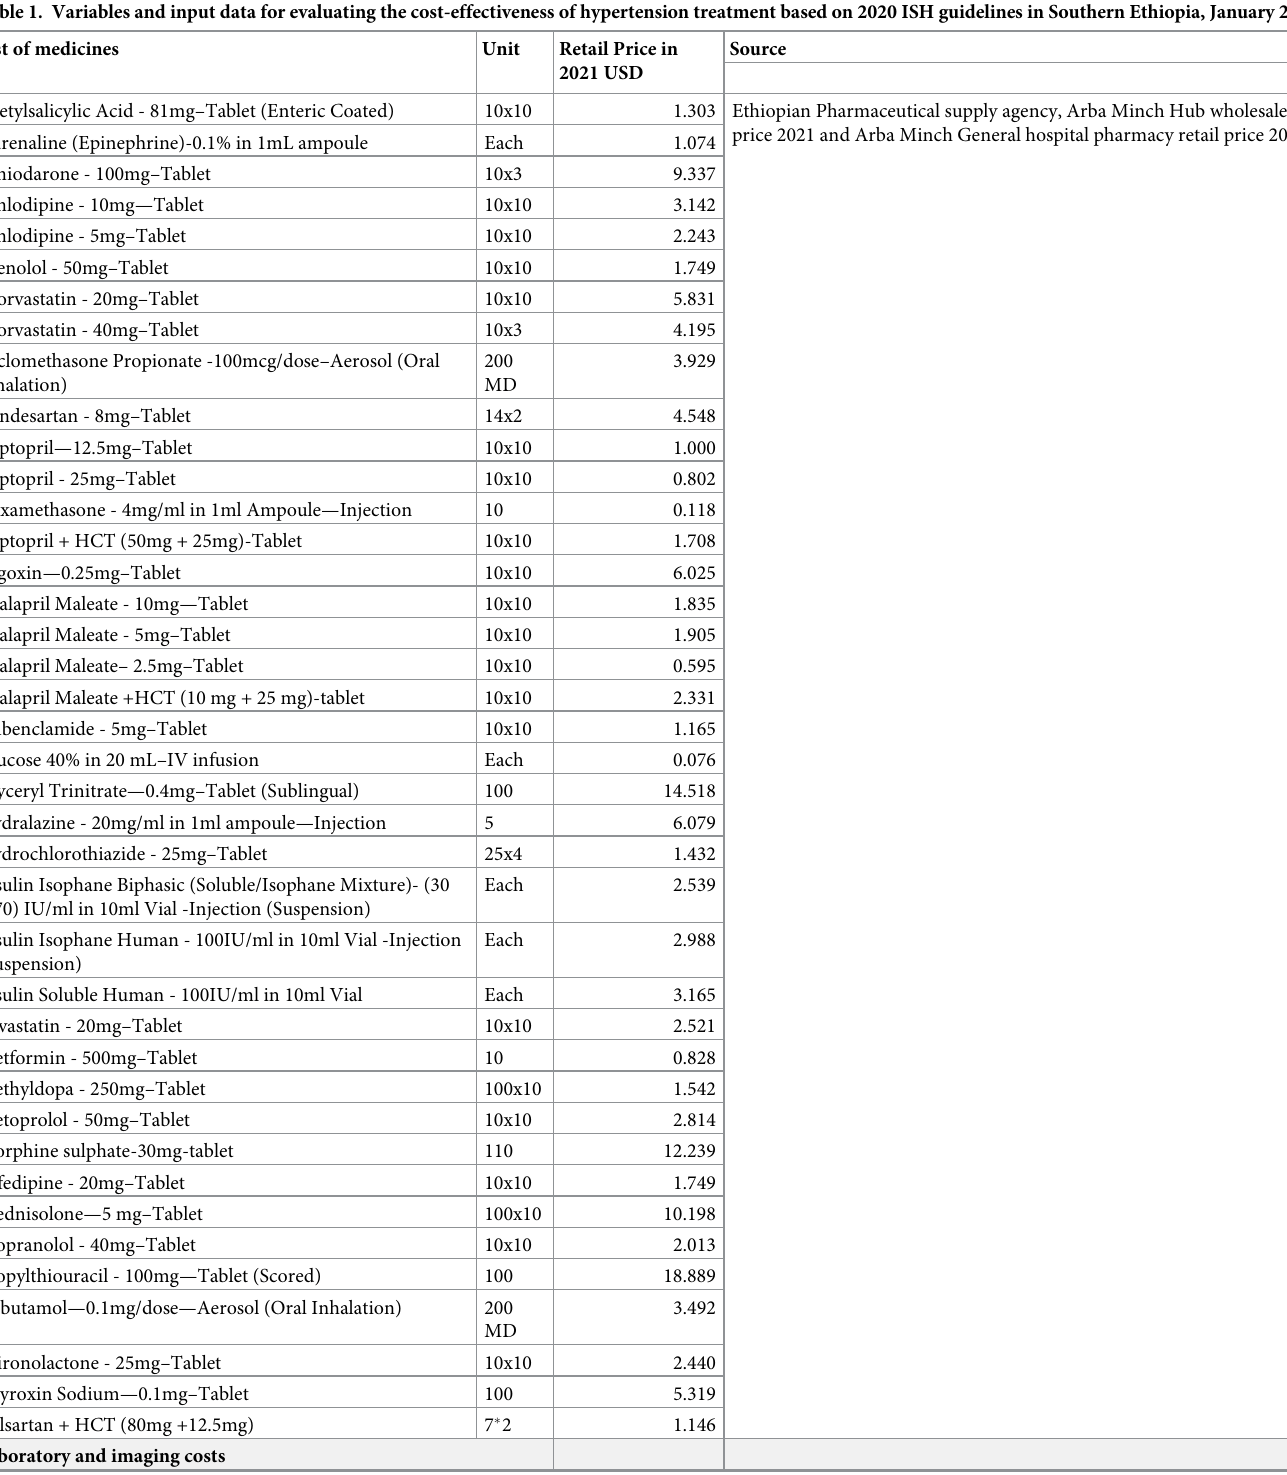
Table 1. Variables and input data for evaluating the cost-effectiveness of hypertension treatment based on 2020 ISH guidelines in Southern Ethiopia, January 2021. List of